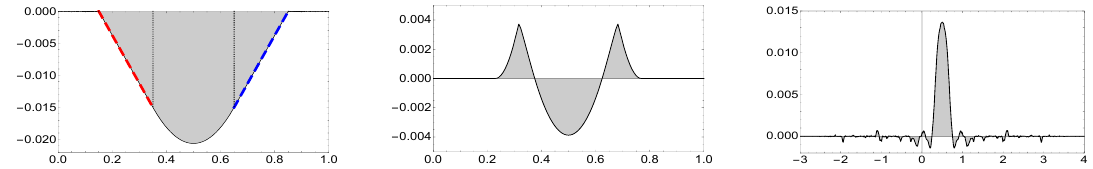
Figure 8. Numerical perturbed breather solution (shadowed region under the solid curve) and self-similar exact solution (dashed lines) for (cid:15) = 0 : 5. Snapshots correspond to (a) t = 0 : 15, (b) t = 0 : 32, (c) t = 7 : 76.